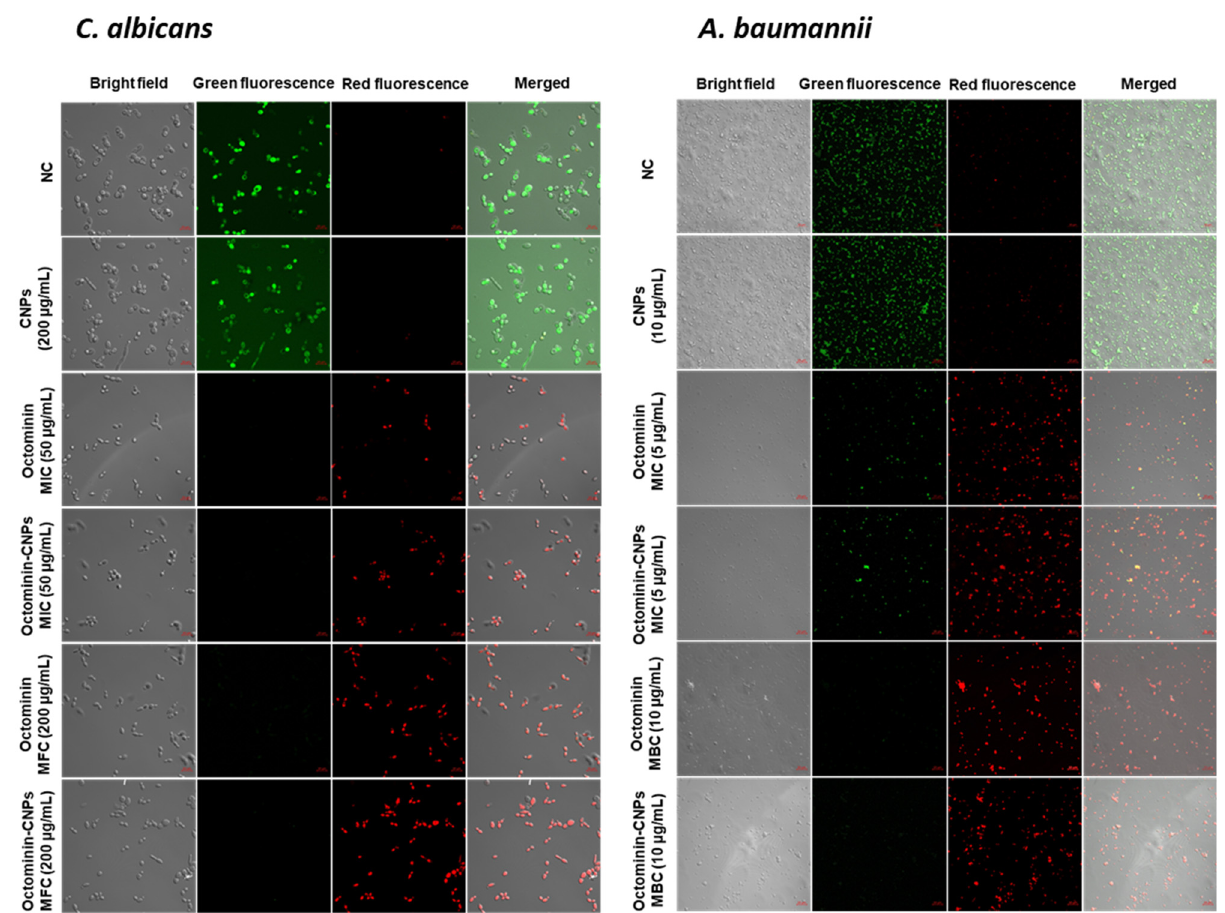
Figure 5. Comparison of membrane permeability alteration in C. albicans and A. baumannii with treatments of Octominin-CNPs, Octominin, and CNPs. C. albicans was treated with PBS (negative control), CNPs (200 µg/mL), Octominin MIC (50 µg/mL), Octominin MFC (200 µg/mL), Octominin-CNPs MIC (50 µg/mL), Octominin-CNPs MFC (200 µg/mL). A. baumannii was treated with PBS